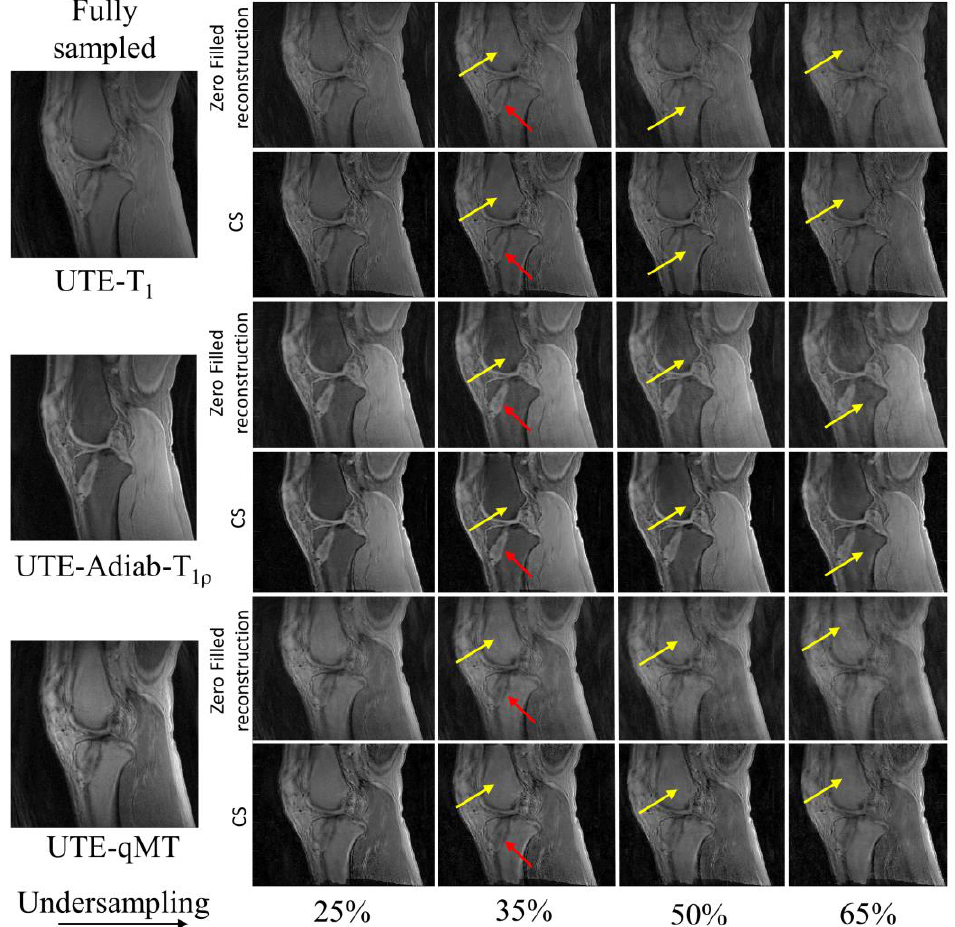
Figure 9. CS reconstruction in a patient with a degenerated knee. As seen, the presence of an abnormality (tibial tunnel from an ACL reconstruction as shown by red arrows) is clearly depicted in images with CS reconstruction. Streaking artifacts in zero-filled reconstruction are dramatically reduced in CS reconstruction (yellow arrows).